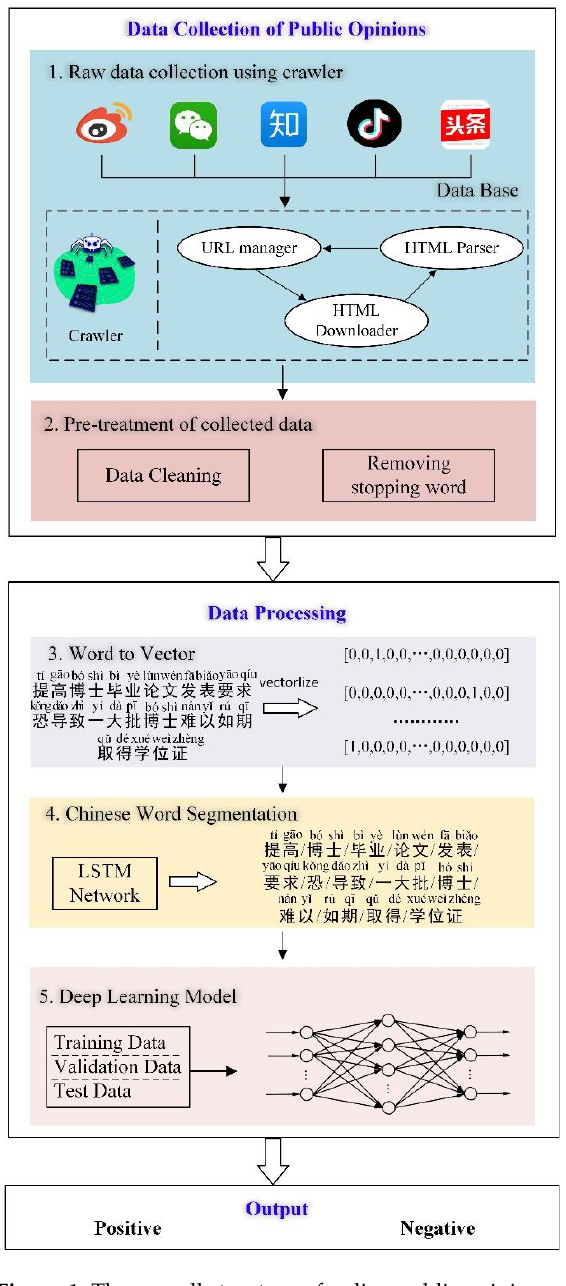
Figure 1. The overall structure of online public opinion analysis model.